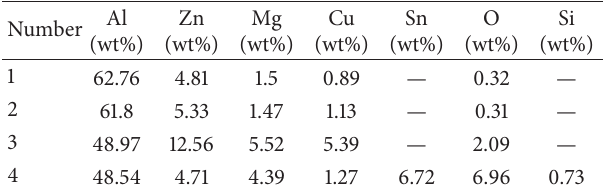
Table 1: Elemental analysis from selected location in Figure 4(b) of sintered Alumix